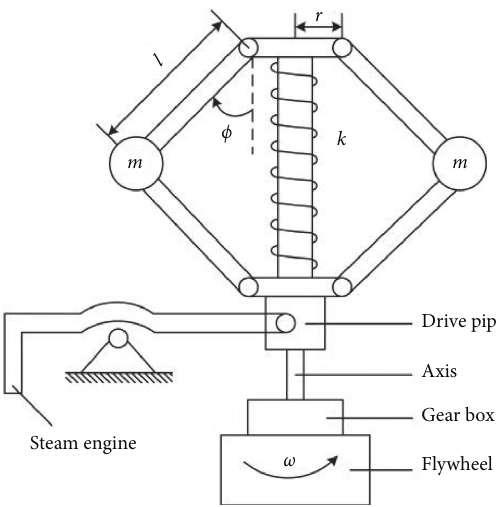
Figure 1: The mechanics model of the centrifugal flywheel gov- ernor